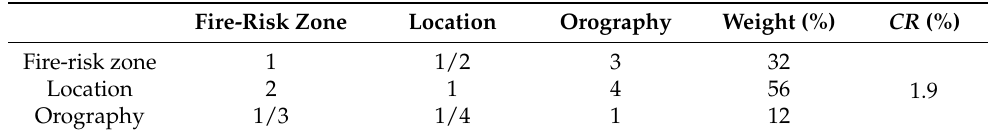
Table 10. Decision matrix of factors.